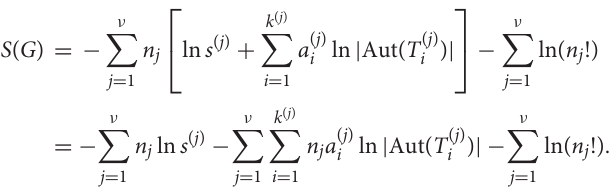
Algorithm 1. Algorithm 2 codes the trees, which helps us sort them out. Algorithm 3 computes the automorphism groups